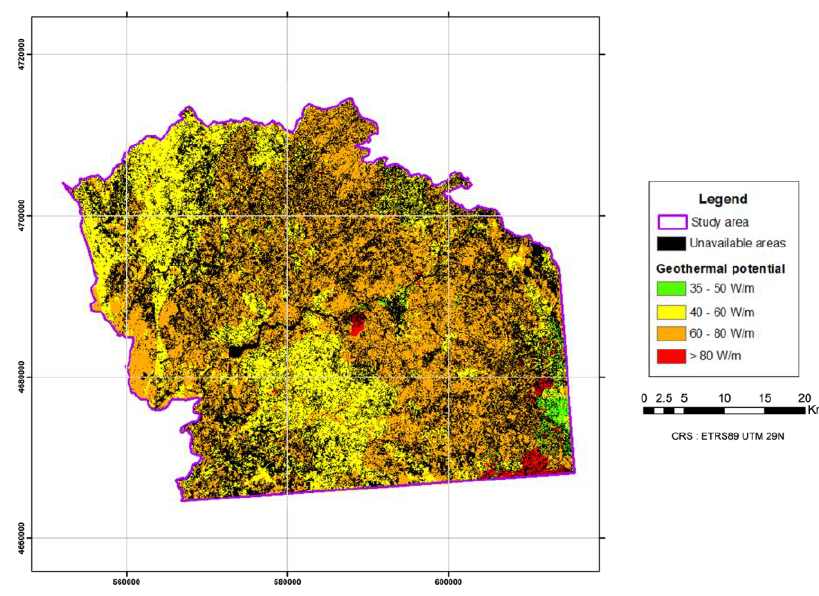
Figure 12. Geothermal potential areas refined on the basis of the land cover map. Table 5. Surface occupied by each geothermal potential class refined on the basis of the land cover map.